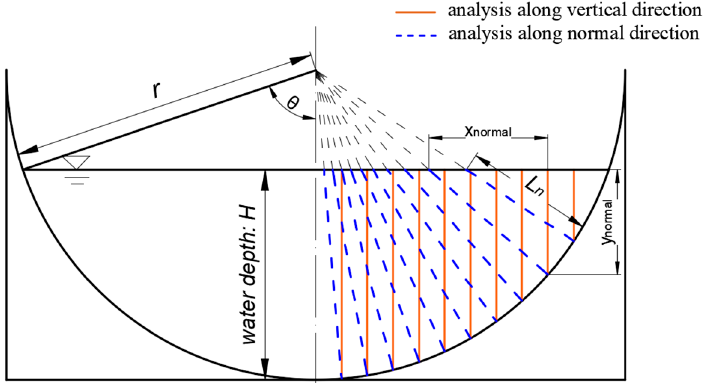
Figure 5. Analysis along vertical or normal direction (red solid line refers to the vertical direction and blue dotted line refers to the normal direction). Here, x normal and y normal are the projection lengths of the line in the horizontal and vertical directions.